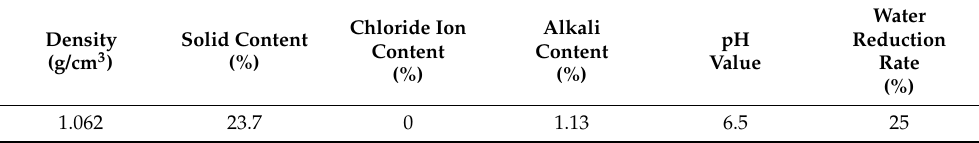
Table 3. Physical and chemical compositions of water-reducing agent.